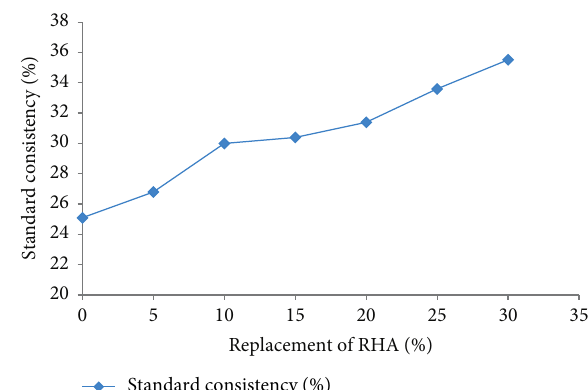
Figure 3: Standard consistency as a function of percentage re- placement of RHA.